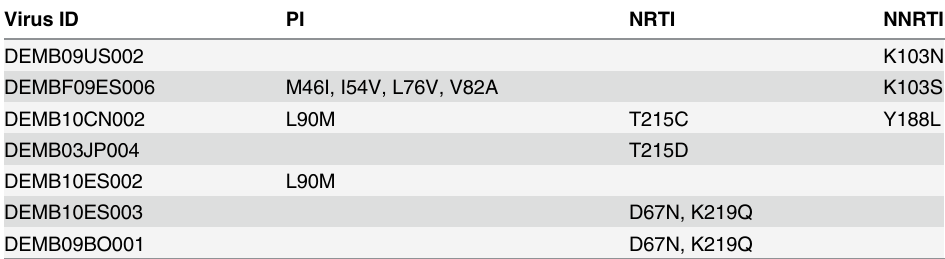
Table 2. Major drug resistance mutations in seven viruses. Virus